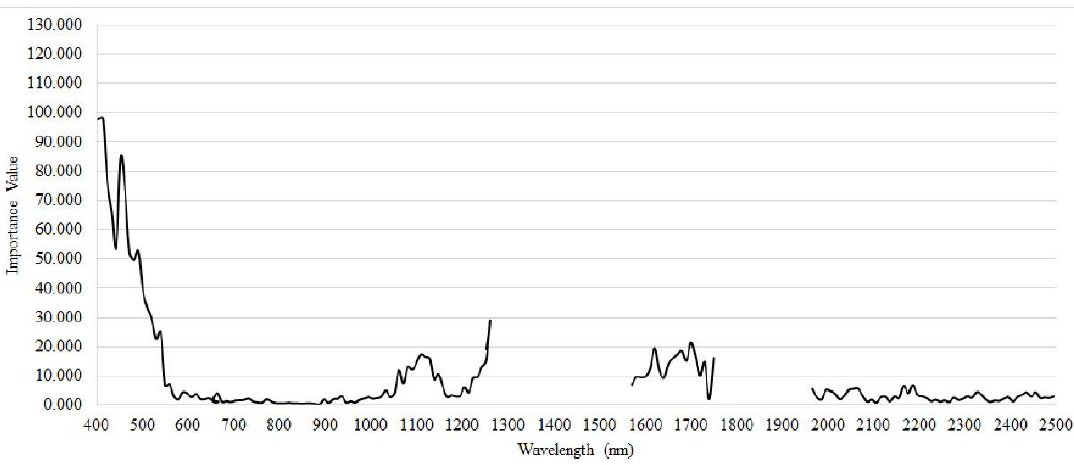
Figure 6. Important value distributions of variables in the AVIRIS wavelength used in this study ( x -axis).